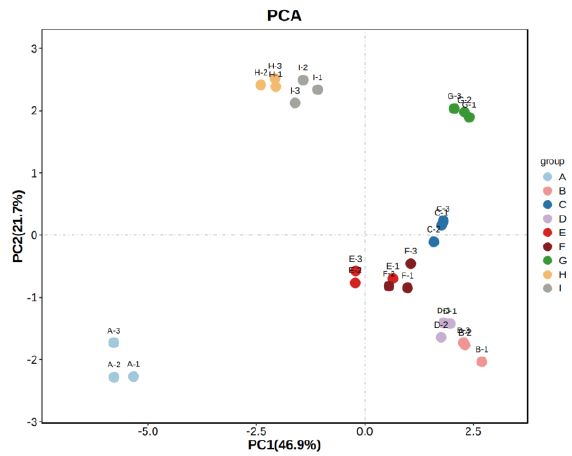
Figure 9. Loading diagram of PCA analysis of volatile aroma compounds with OAV values greater than 1 in nine wine varieties.